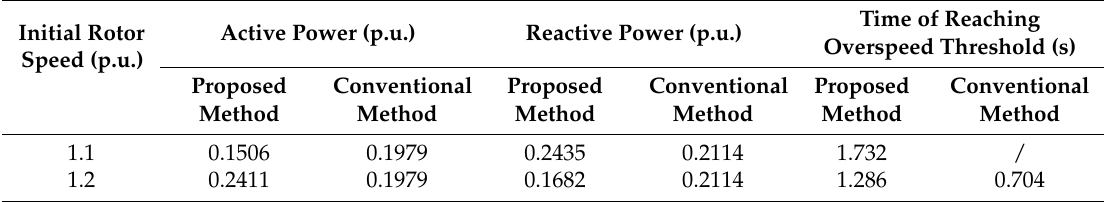
Table 2. Comparison between proposed method and conventional method with terminal voltage of 0.3 p.u. Initial Rotor Speed